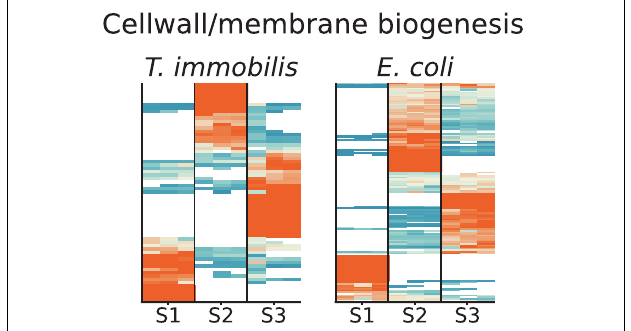
FIGURE 5 | Heatmap showing the relative abundance of 65 expressed proteins in T. immobilis and 133 proteins in E. coli belonging to the Cluster of Orthologous Group (COG) category “Cell wall/envelope biogenesis” (M) as a function of the respective subcellular fraction [Tris soluble (S1), Tris/TX-100 soluble (S2), and Tris/SDS soluble (S3)]. The heatmaps are colored according to the scale shown in Figure 4 .